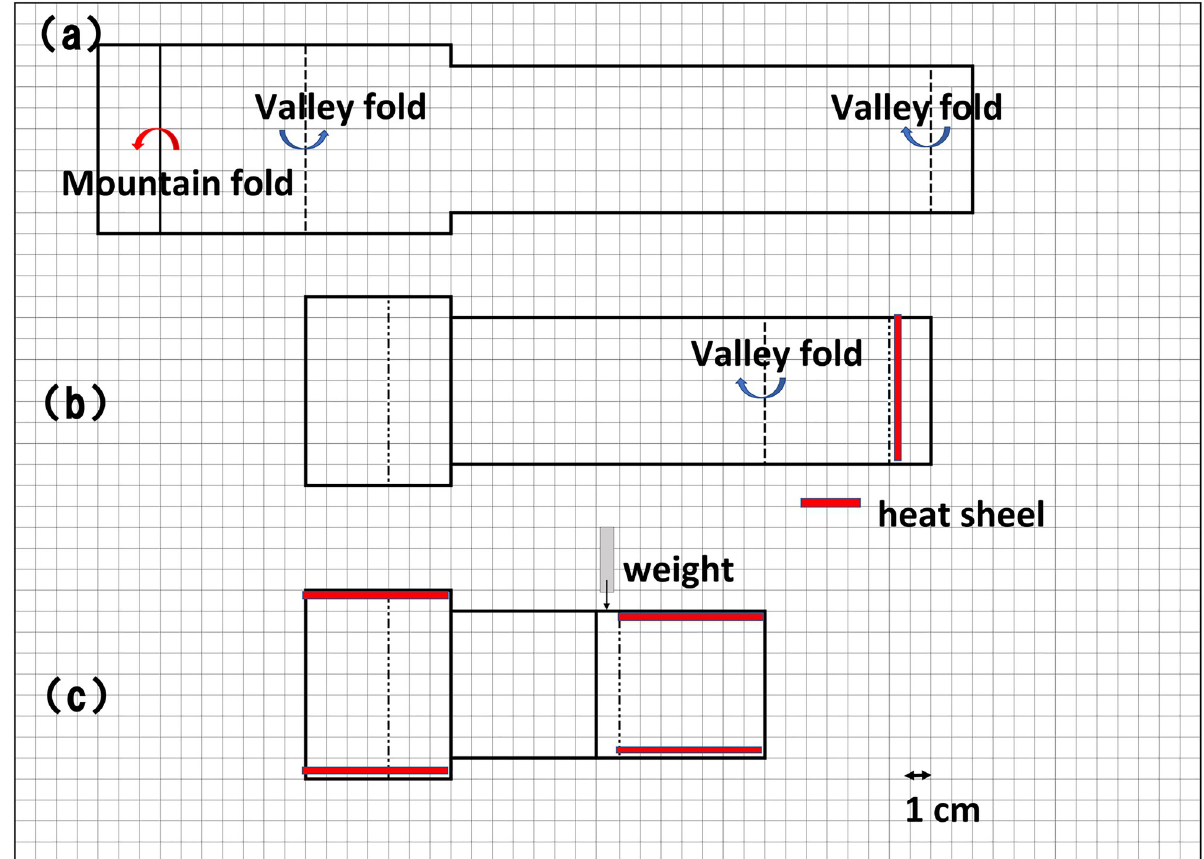
Fig 1. The development of a sheet pocket. Illustration of the three folding steps for pocket creation. (A) Mountain folding (the fold is made by folding the bottom edge behind the sheet and away from you) along the solid line and valley folding (the fold is made by folding the bottom edge of the sheet up towards you and then down to lay over the surface of the sheet) along the dashed line. (B) The addition of a heat seal to create the weight insertion area. A weight was inserted when the pocket was not fully immersed in the solution because of an air pocket. (C) Adhesion with a heat seal to create two